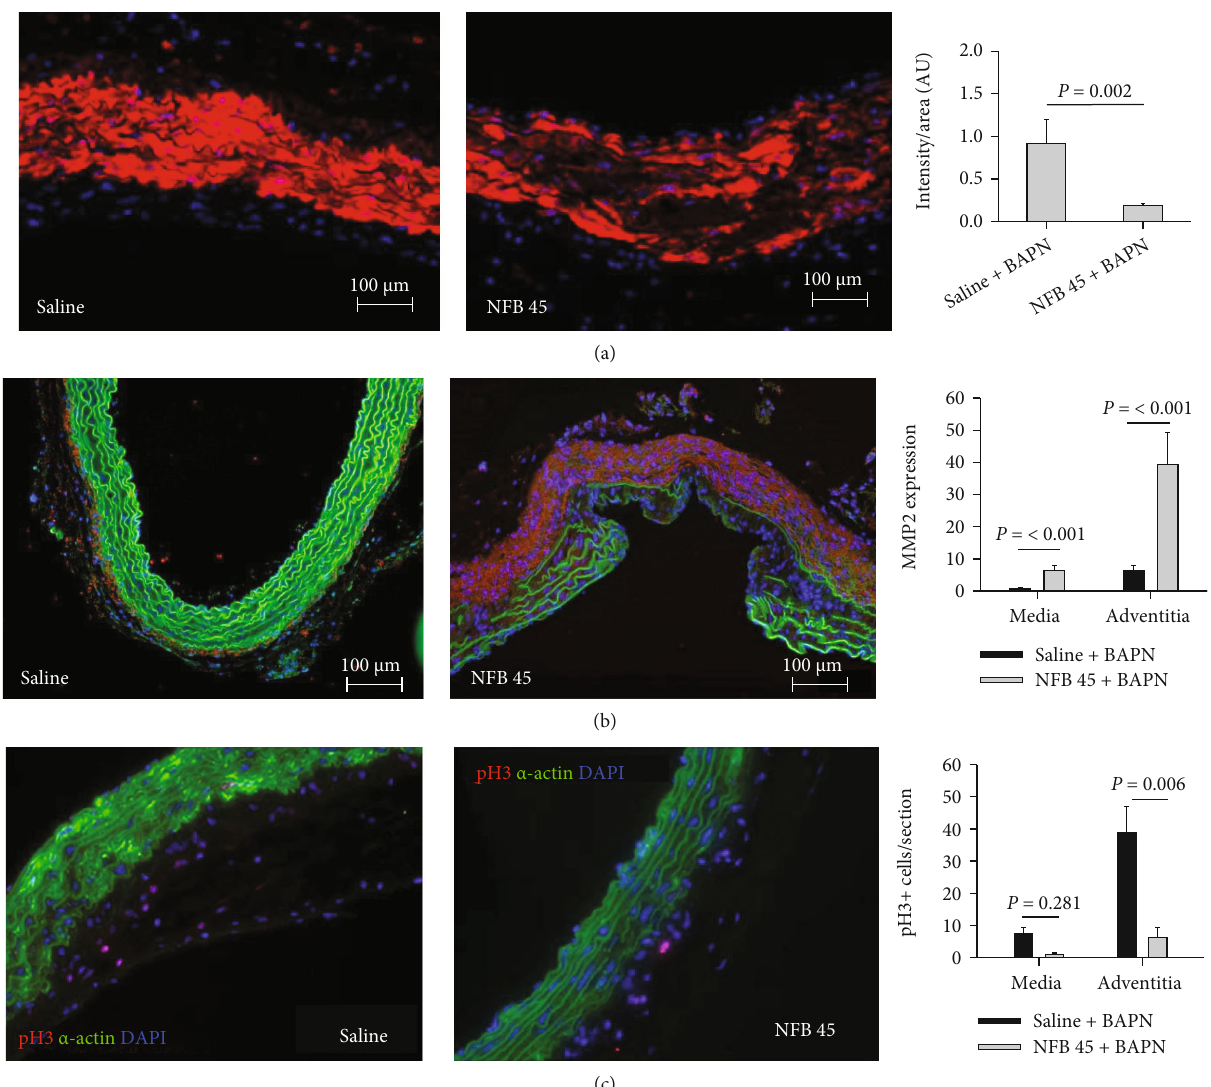
Figure 4: Chronic infusion of nicotine promotes phenotypic switching of smooth muscle cells to a synthetic phenotype in TAADs. (a – c) Assessment of production of α -actin (red, (a)), matrix metalloproteinase-2 (MMP-2, red, (b)), and phosphorylated histone 3 (pH3, red, (c)) in TAADs, by IF staining ( n = 5 ‐ 6 per condition). Blue: DAPI counterstain; green: auto fl uorescence (b) or α -actin (c). Measurements were normalized to the corresponding area and plotted in the bar graphs shown at the right. Data were analyzed using Student ’ s t